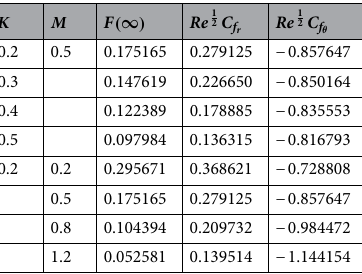
Table 2. Computational results of skin friction coefficients at different values of K and M at 20th-order of approximations.